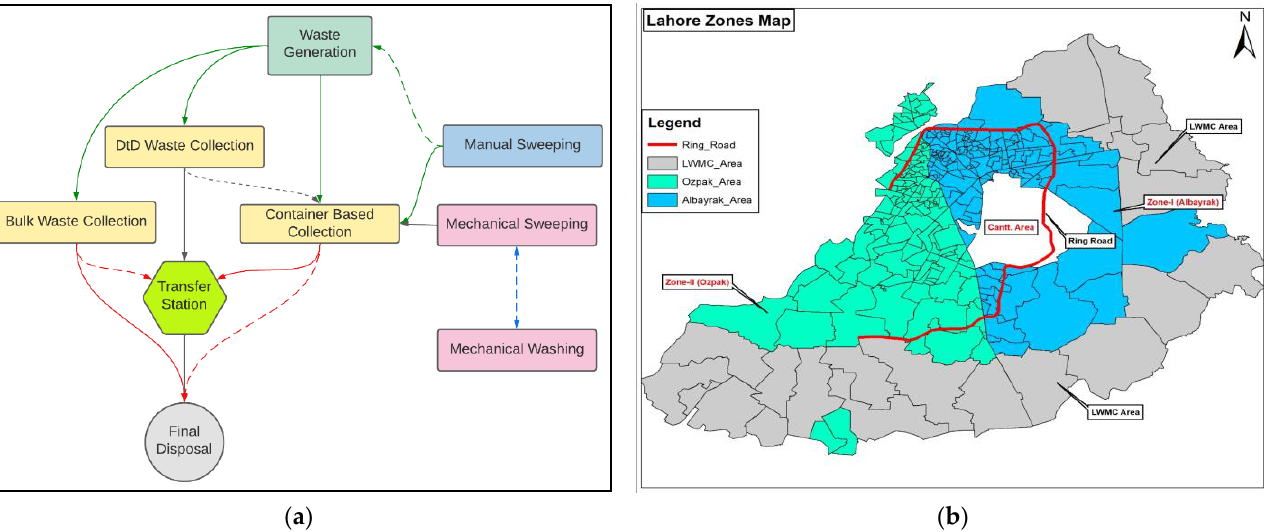
Figure 6. Outsourcing of waste collection services: ( a ) Scope of outsourced services; ( b ) Map of Lahore showing outsourced service area to contractors.